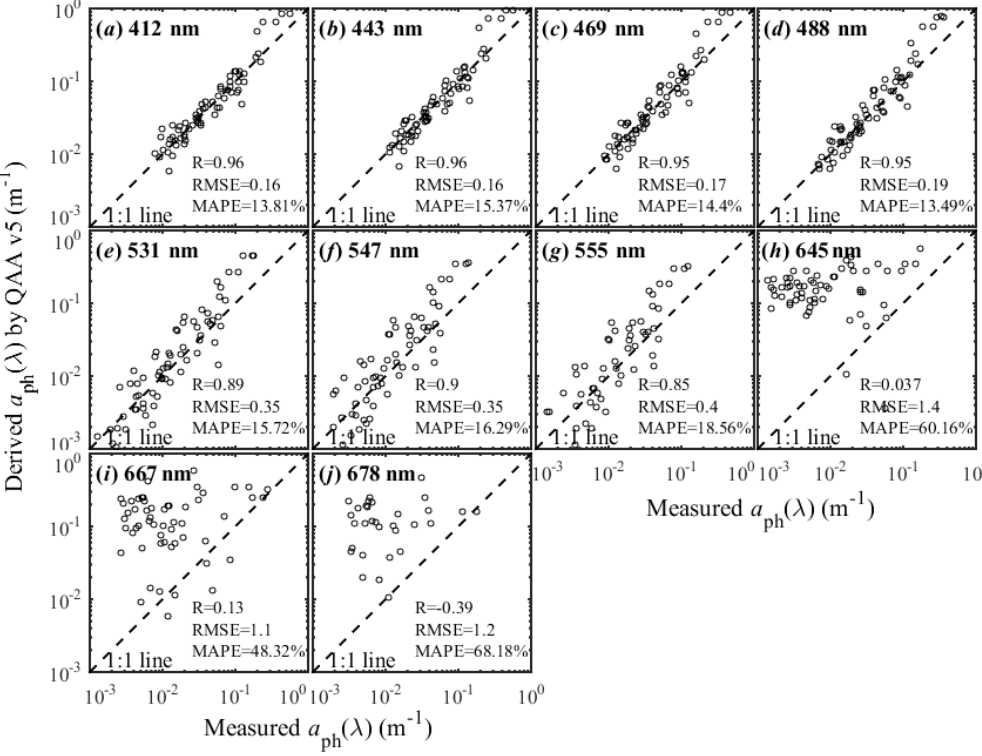
Figure 4. Comparison of a ph derived from R rs using QAA_v5 with in situ measured a ph data.